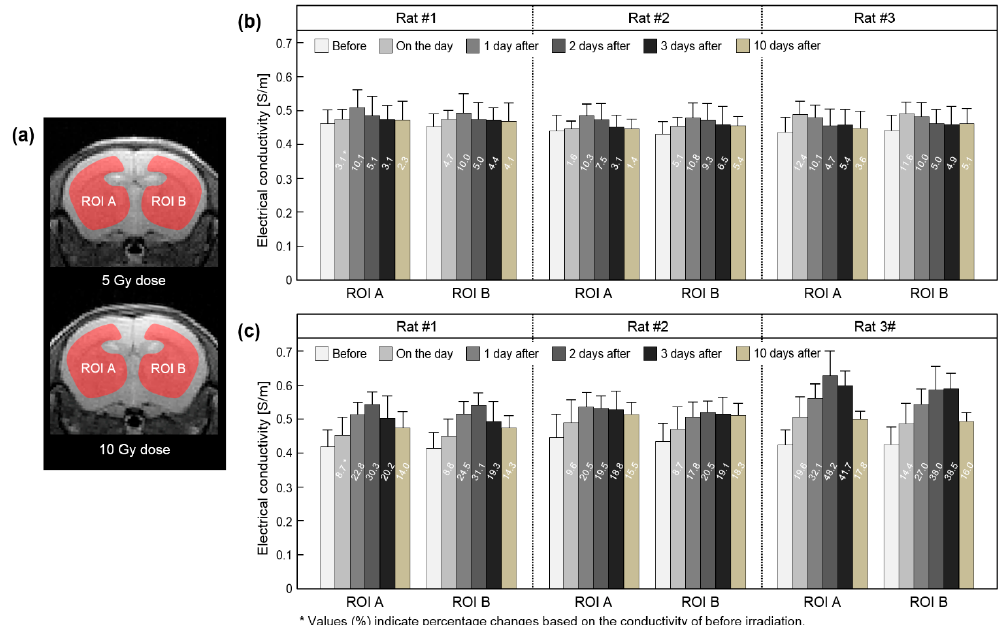
Figure 6. Measurement of absolute conductivity in brain tissues at full time points. ROIs were located in both hemispheres ( a ), and the conductivity was measured at 5 Gy ( b ) and 10 Gy ( c ) irradiation doses. The values inside the bar graph indicate relative conductivity changes.